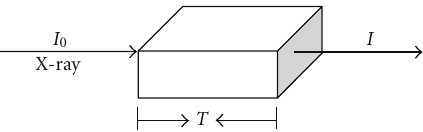
Figure 1: Attenuation diagram of X-ray imaging